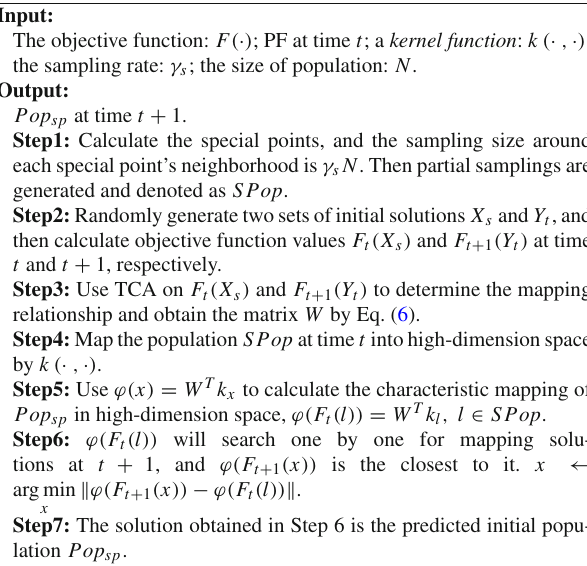
Algorithm 2 Prediction strategy based on